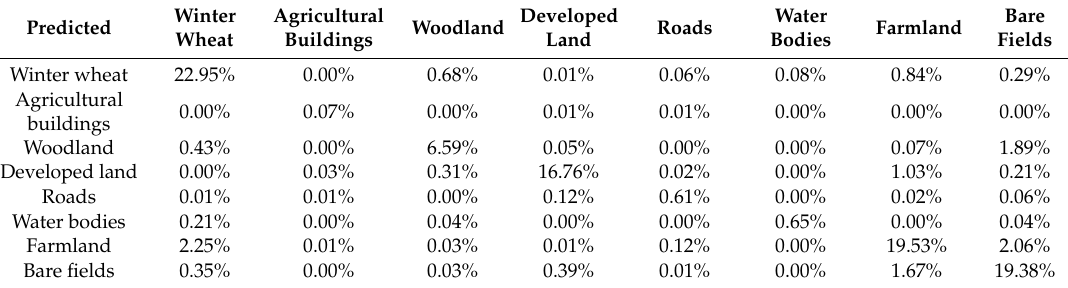
Table 6. Confusion matrix for the RefineNet